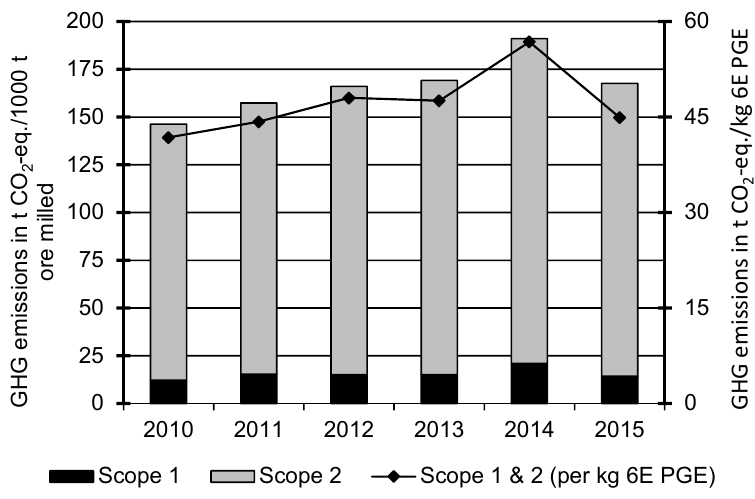
Figure 8. GHG emissions (Scope 1 and 2): per t ore milled ( left axis ); and per kg 6E PGE ( right axis ). Based on data from [15,54–84].